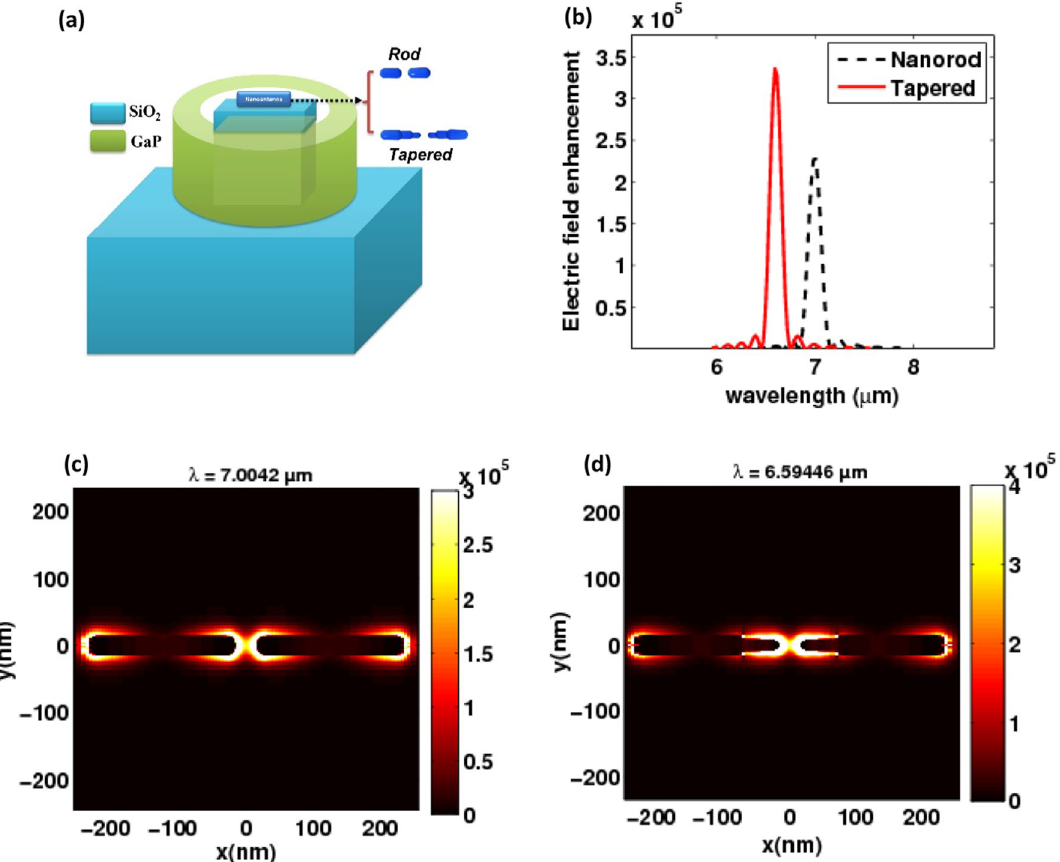
Figure 12. ( a ) The nanorod and tapered coupled structure on a substrate of n = 1.46, ( b ) the electric field enhancement inside the gap as a function of the wavelength, and ( c ) the corresponding electric field profiles at the resonance